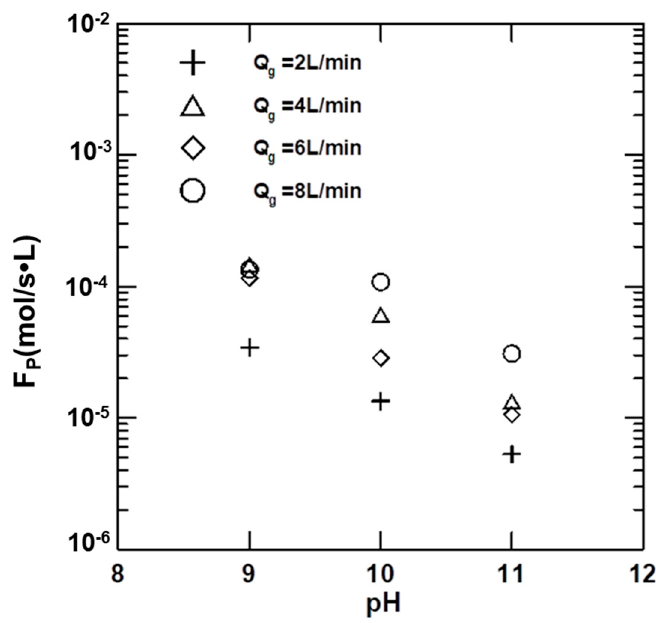
Figure 12. Variation in F p with pH at different Q g values.